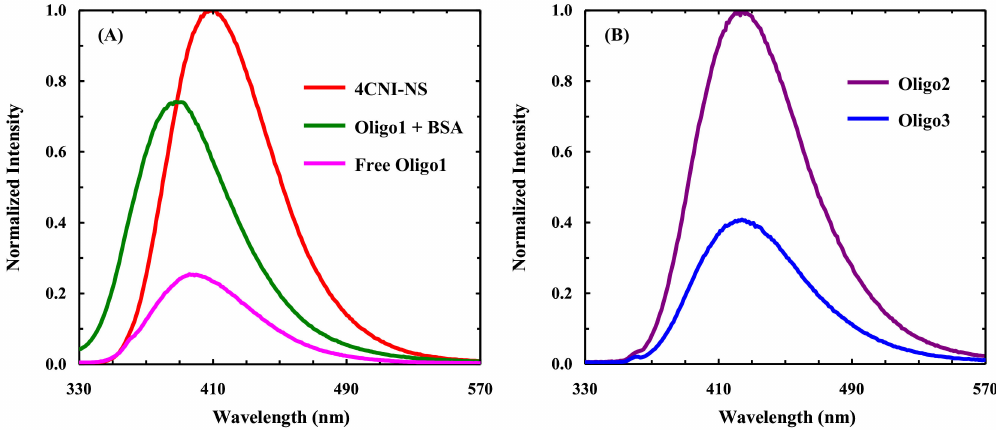
Figure 3. ( A ) Normalized fluorescence spectra of 4-cyanoindole-2 (cid:48) -deoxyribonucleoside (4CNI-NS), free Oligo1, and an Oligo1-BSA mixture, as indicated. ( B ) Normalized fluorescence spectra of Oligo2 and Oligo3, as indicated. These spectra were collected under the same experimental conditions (i.e., temperature, excitation/emission slit, and fluorophore absorbance at λ ex = 320